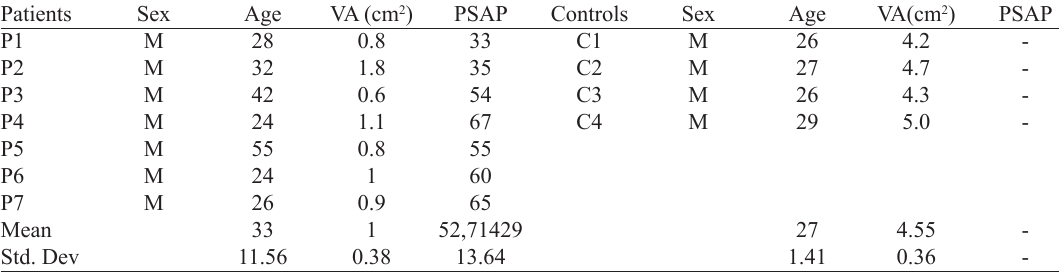
Table 1. Epidemiological profile of patients and controls.